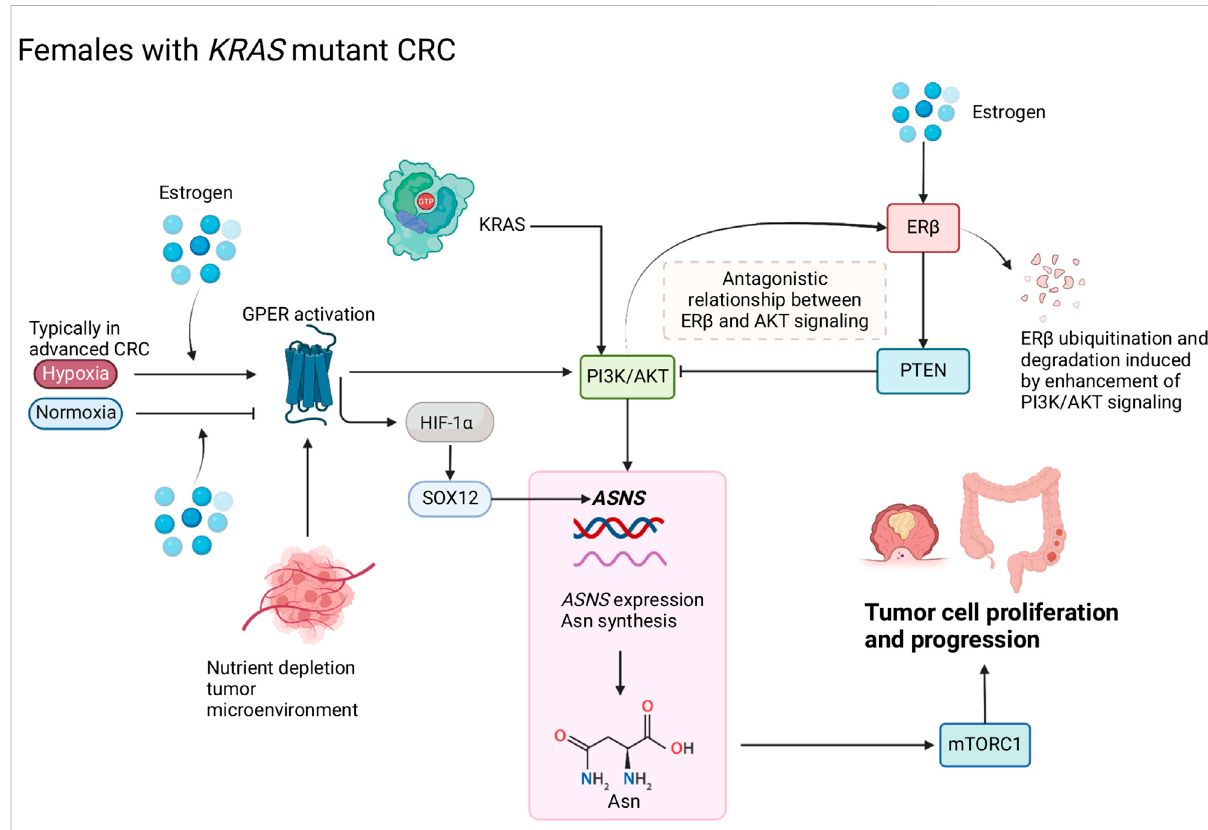
FIGURE 2 SchematicofAsnbioavailabilityandAsnmetabolisminfemalepatientswithCRC.Estrogenregulatestheantagonistic relationship betweenER β andAKTsignaling.OxygenlevelsmodifythefunctionofestrogenandGPERthattargethypoxia-induciblefactor(HIF)-1 α andsubsequentlyin fl uence Asn synthesis through PI3K/AKT signaling. Created with